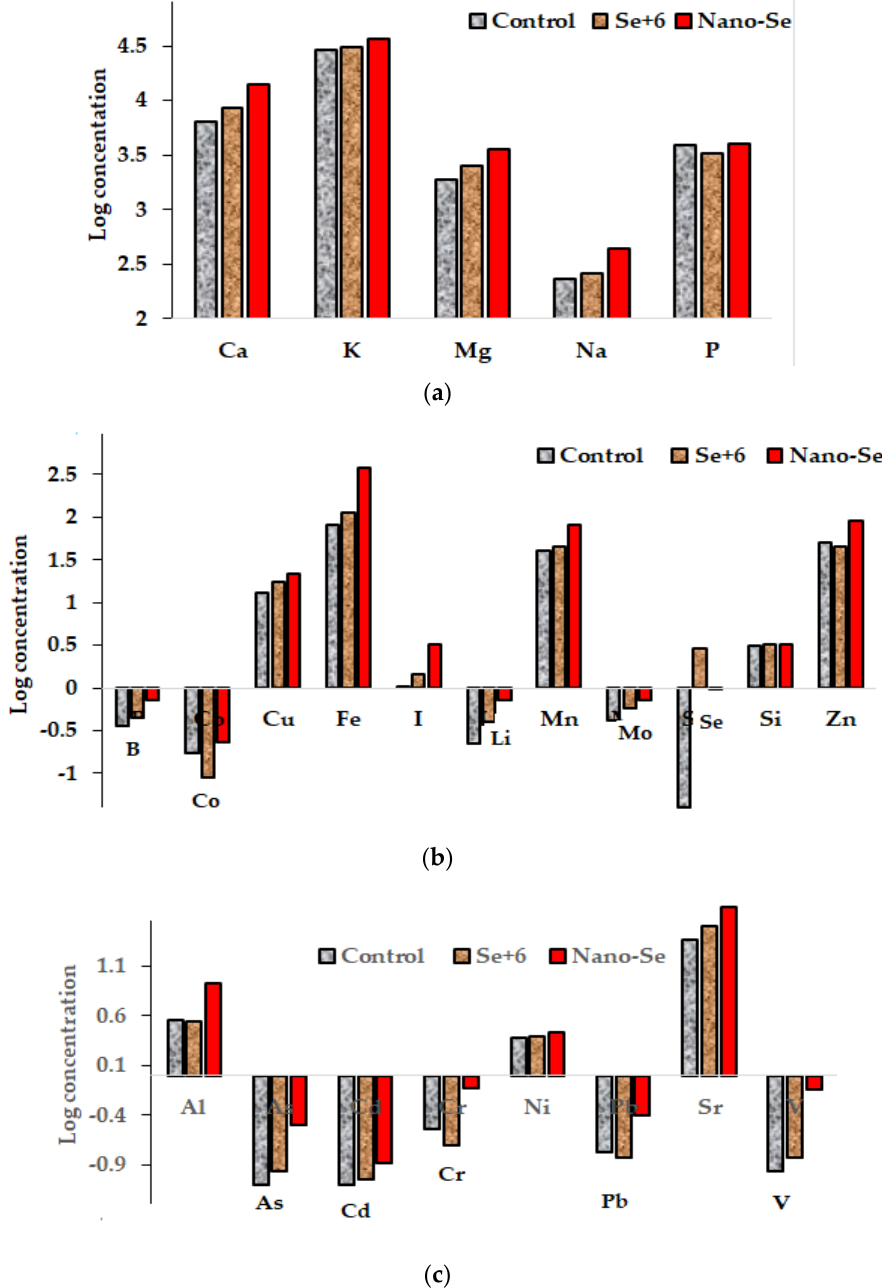
Figure 6. Effect of Se foliar biofortification on mineral composition of A. annua leaves: ( a ) macroelements; ( b ) microelements; ( c ) Al, As and heavy metals.